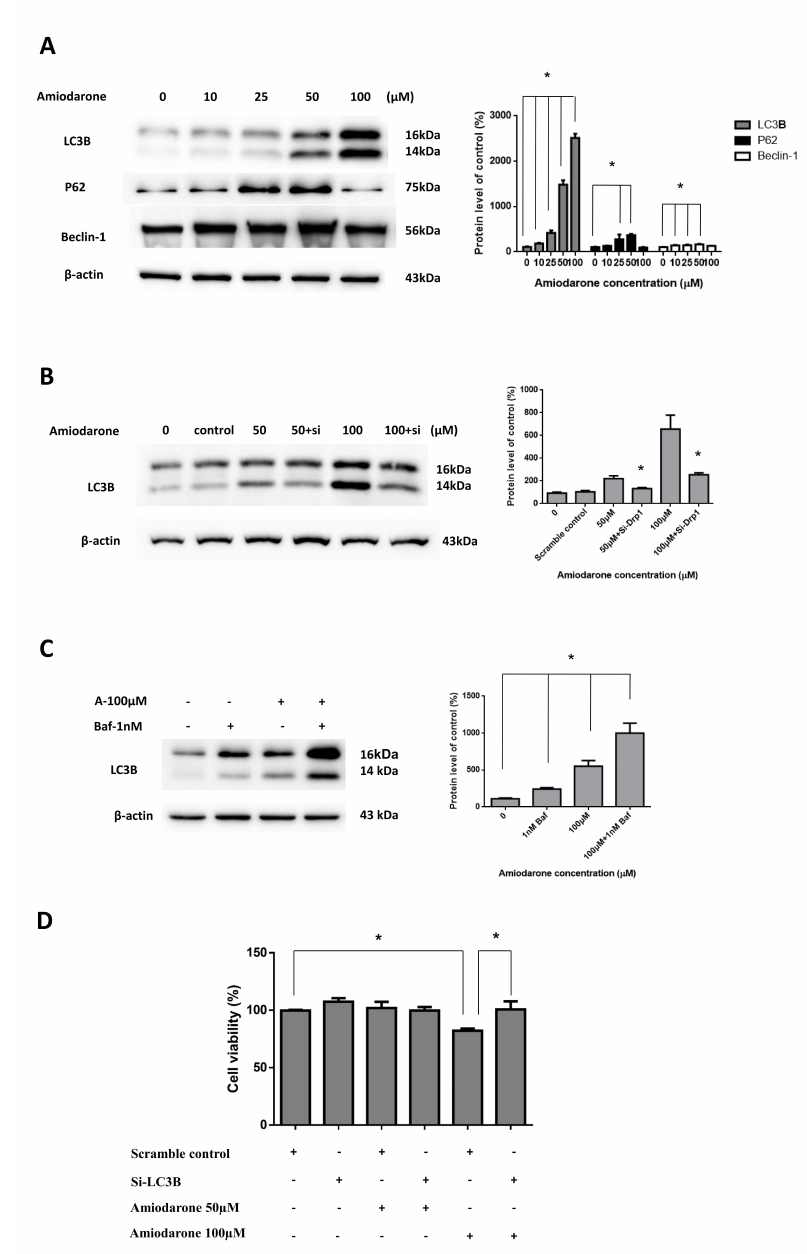
Figure 5. Stimulation of autophagy in HepG2 cells following amiodarone treatment. ( A ) Conversions of LC3B-I to LC3B-II and upregulation of P62 and beclin-1 were detected by immunoblotting following various concentrations of amiodarone treatment in HepG2 cells for 24 h. ( B ) E ff ect of LC3B-siRNA on the cellular LC3B protein was detected by immunoblotting in HepG2 cells. They were transfected with LC3B and scrambled siRNAs and co-treated with amiodarone (50 and 100 µ M) for 24h. ( C ) HepG2 cells were pretreated with bafilomycin-A1 (1nM, 2h) and then co-treated with amiodarone (100 µ M) for 24 h to indicate increased autophagic flux. The cells were extracted and the protein levels were measured by immunoblotting. β -actin served as loading control. ( D ) LC3B silencing reversed the reduction of HepG2 cell viability with the treatment of amiodarone. Results are representative of three independent experiments. The results are expressed as the means ± SD from three independent experiments (n (cid:61) 3, * p < 0.05 compared with untreated